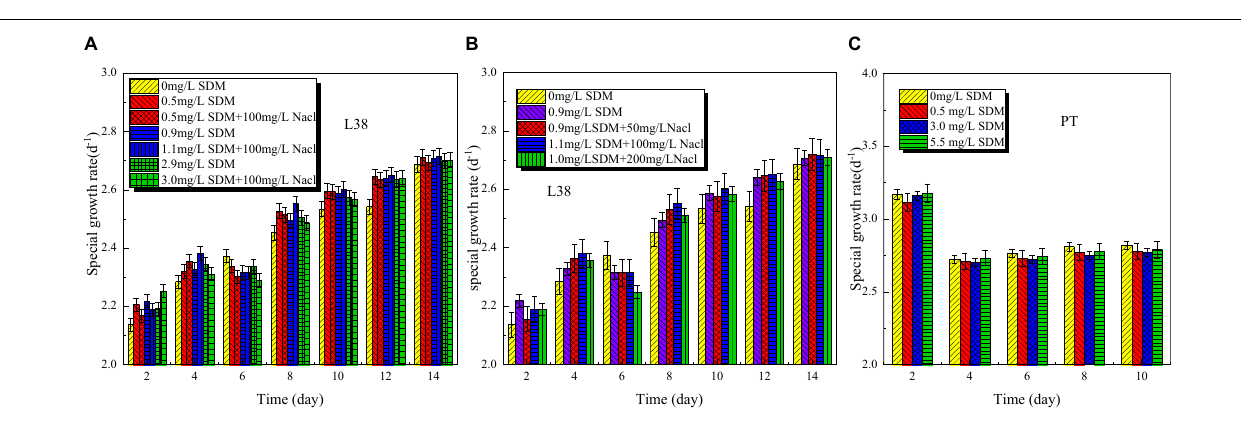
FIGURE 2 | Specific growth rate variation of Chlorella sp. L38 (A,B) and Phaeodactylum tricornutum MASCC-0025 (C) under different SDM